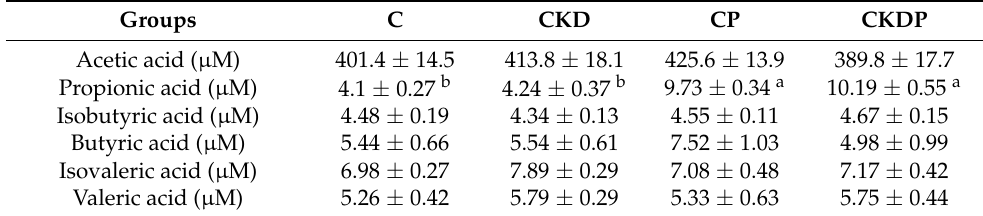
Table 3. Plasma SCFA levels in offspring at 12 weeks of age.